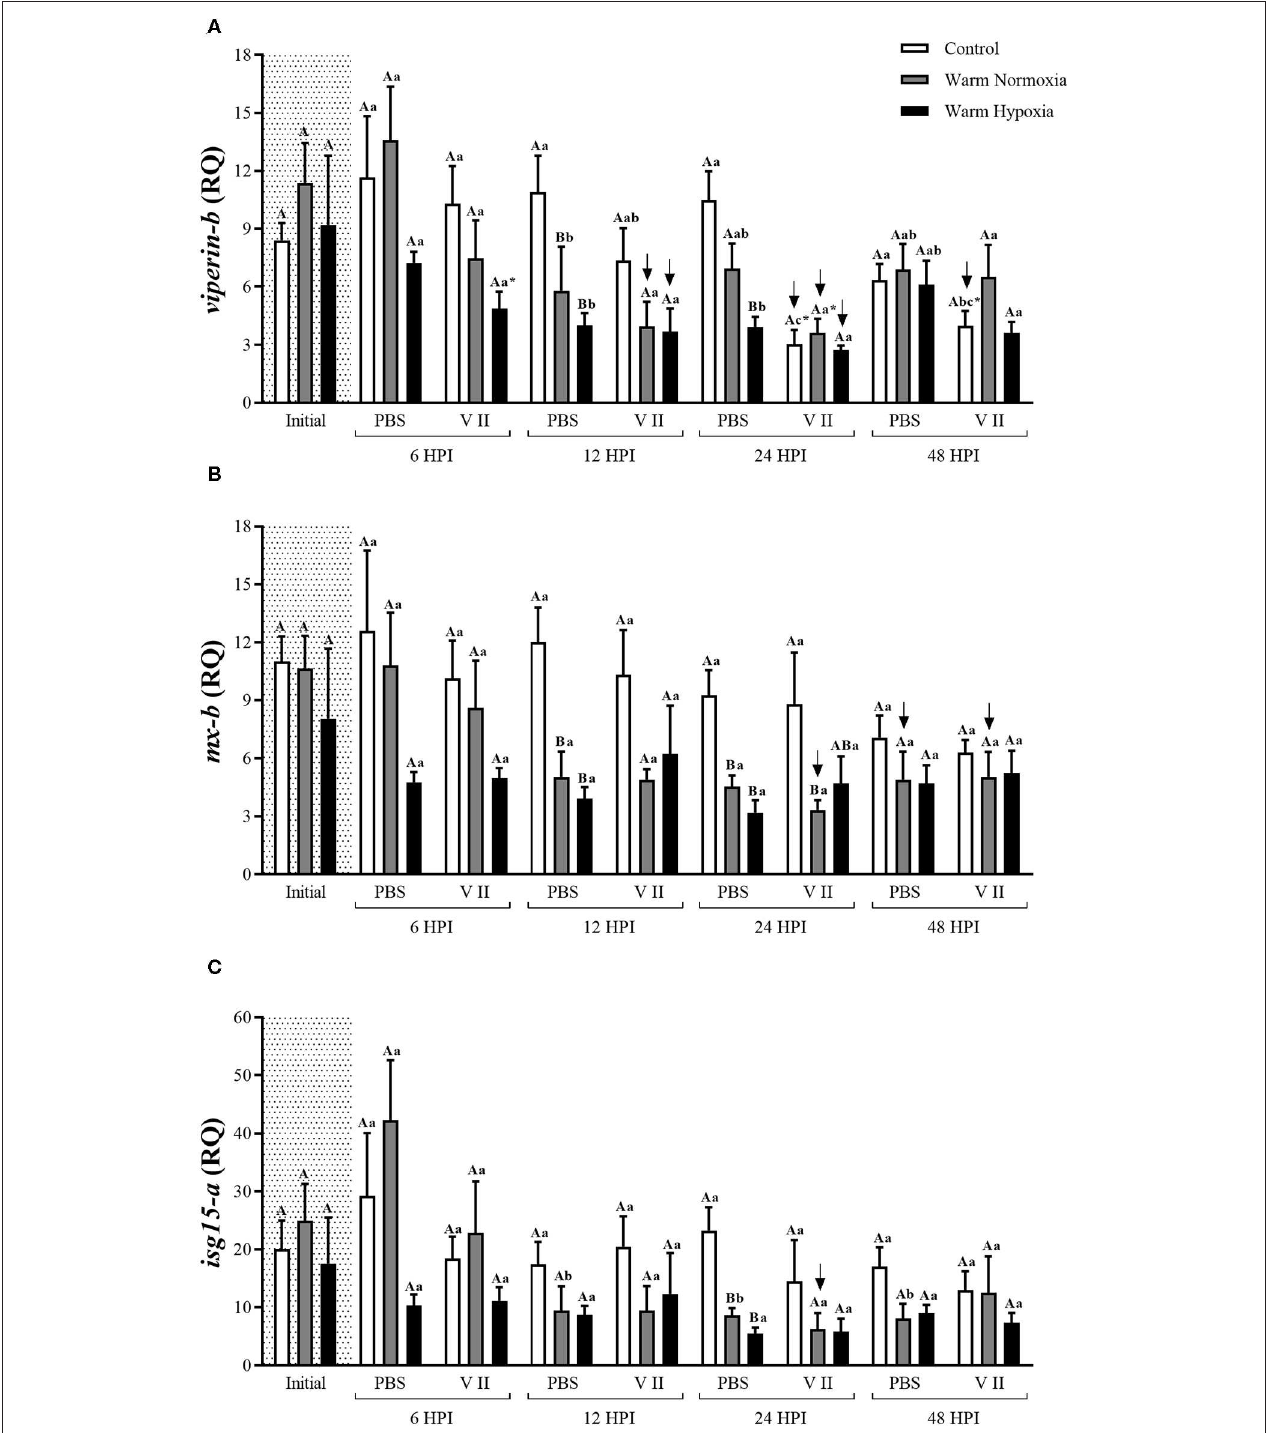
FIGURE 4 | Transcript expression levels of 3 anti-viral biomarkers [ viperin-b (A) , mx-b (B) , and isg15-a (C) ] in the head kidney of salmon held at 12 ◦ C (under normoxia) or 20 ◦ C (under normoxia or mild hypoxia) (i.e., treatment) 6, 12, 24, and 48h post-intraperitoneal injection with PBS or Forte V II (i.e., injection group). Different capital letters indicate a significant difference ( P < 0.05) among treatments within an injection group at a given time point (e.g., the three treatments 6 HPI after PBS injection) whereas dissimilar lower case letters indicate a significant difference over time within a treatment/group combination (e.g., control PBS-treated at 6, 12, 24, and 48 HPI). An asterisk (*) indicates a significant difference between PBS and Forte V II injection groups within a treatment at the same time point post-injection. The arrows indicate a significant difference compared with initial (constitutive expression) levels, within an injection group. Transcript levels are presented as mean ± SE relative quantity (RQ) values (i.e., values for the transcript of interest were normalized to both etif3d and pabpc1 transcript levels and were calibrated to the individual with the lowest normalized expression level of that given transcript). N = 7–8.